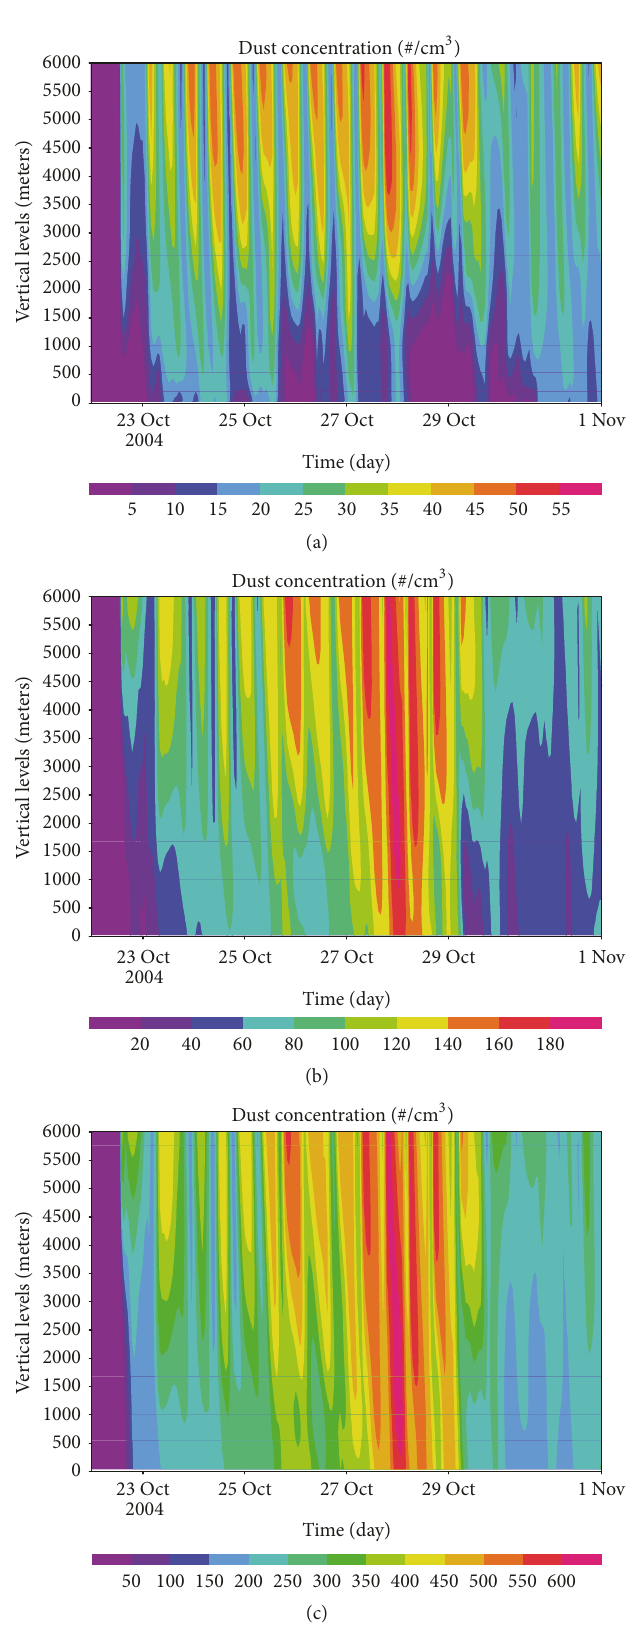
Figure 3: Daily average dust concentration profile for a1d1 for Case Study 1 (a); daily average dust concentration profile for a1d3 for Case Study 1 (b); daily average dust concentration profile for a1d10 for Case Study 1